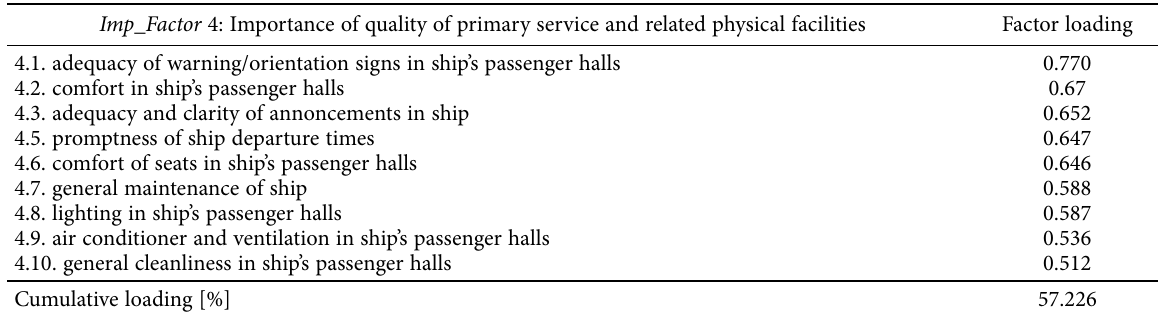
Table 14. Importance Factor 4 factor loadings